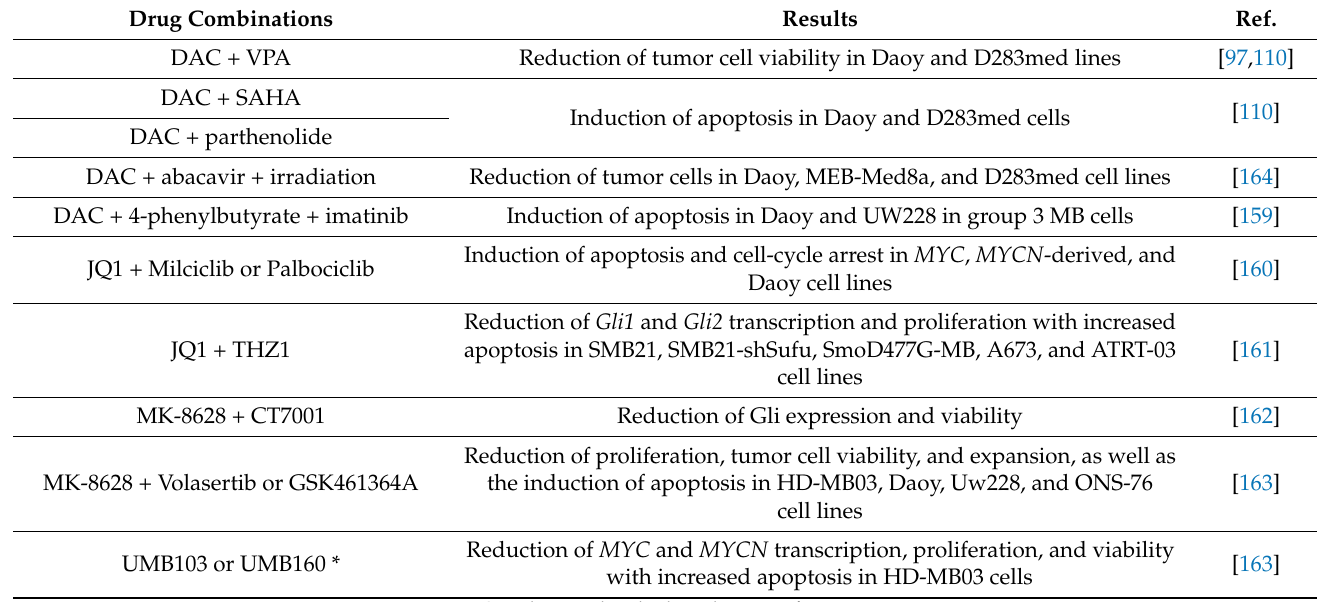
Table 6. The list of the combined therapies that are available against medulloblastoma. Drug Combinations Results Ref. DAC + VPA Reduction of tumor cell viability in Daoy and D283med